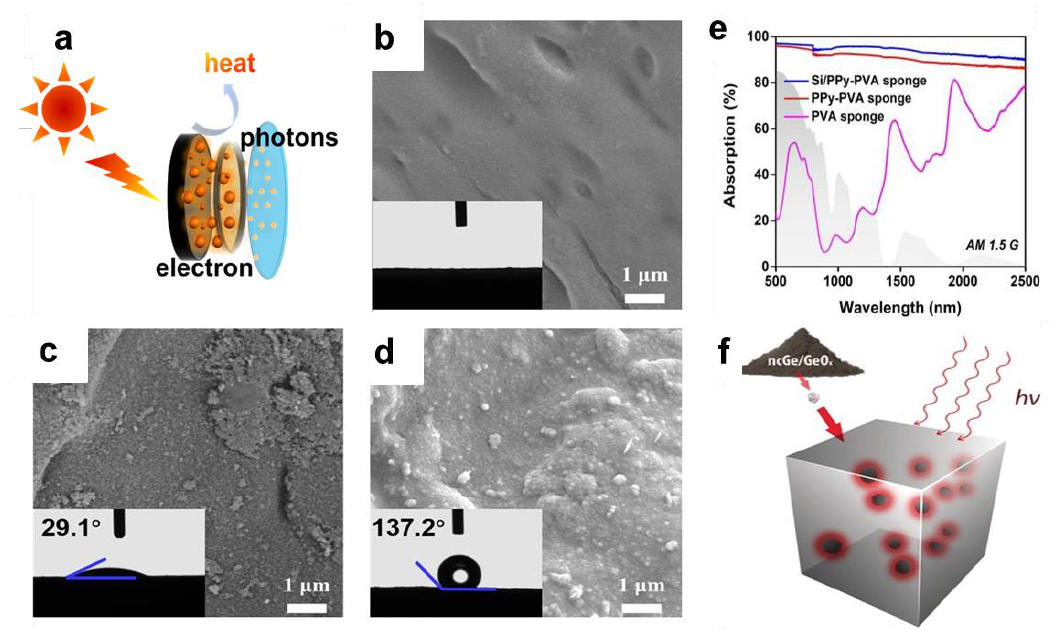
Figure 8. The fourth group of semiconductor nanomaterials is used as photothermal conversion materials. ( a ) Semiconductor photothermal conversion mechanism diagram; ( b ) PVA sponge fibers. Reprinted with permission from Ref. [89]. Copyright 2020 American Association for the Chemical Engineering Journal; ( c ) PPy-PVA sponge fibers.Reprinted with permission from Ref. [89]. Copy- right 2020 American Association for the Chemical Engineering Journal; ( d ) Si/PPy-PVA sponge fi-